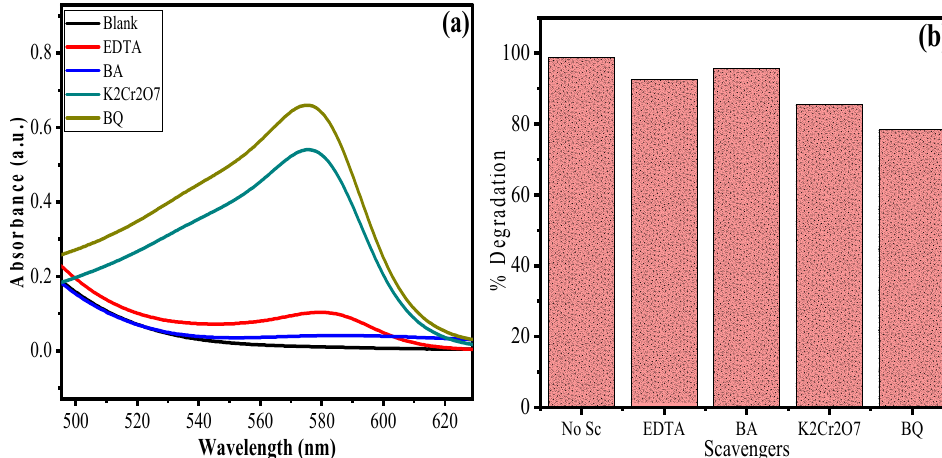
Figure 11. ( a ) UV–vis spectra of XO degradation in the presence of various scavengers; ( b ) % XO degradation vs. bar graph associated with each scavenger.